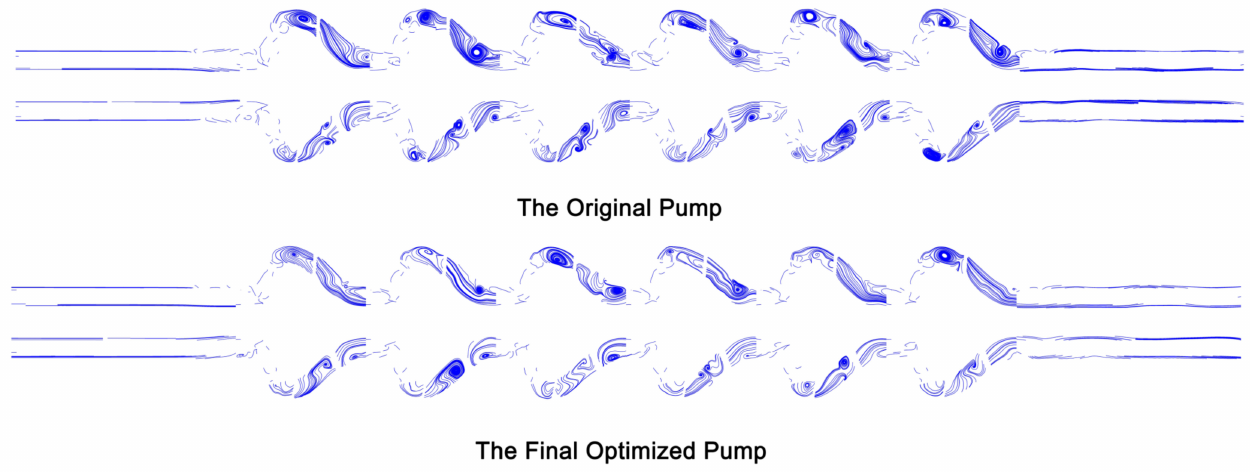
Figure 13. The streamlines on the shaft cross-section of the original and optimized